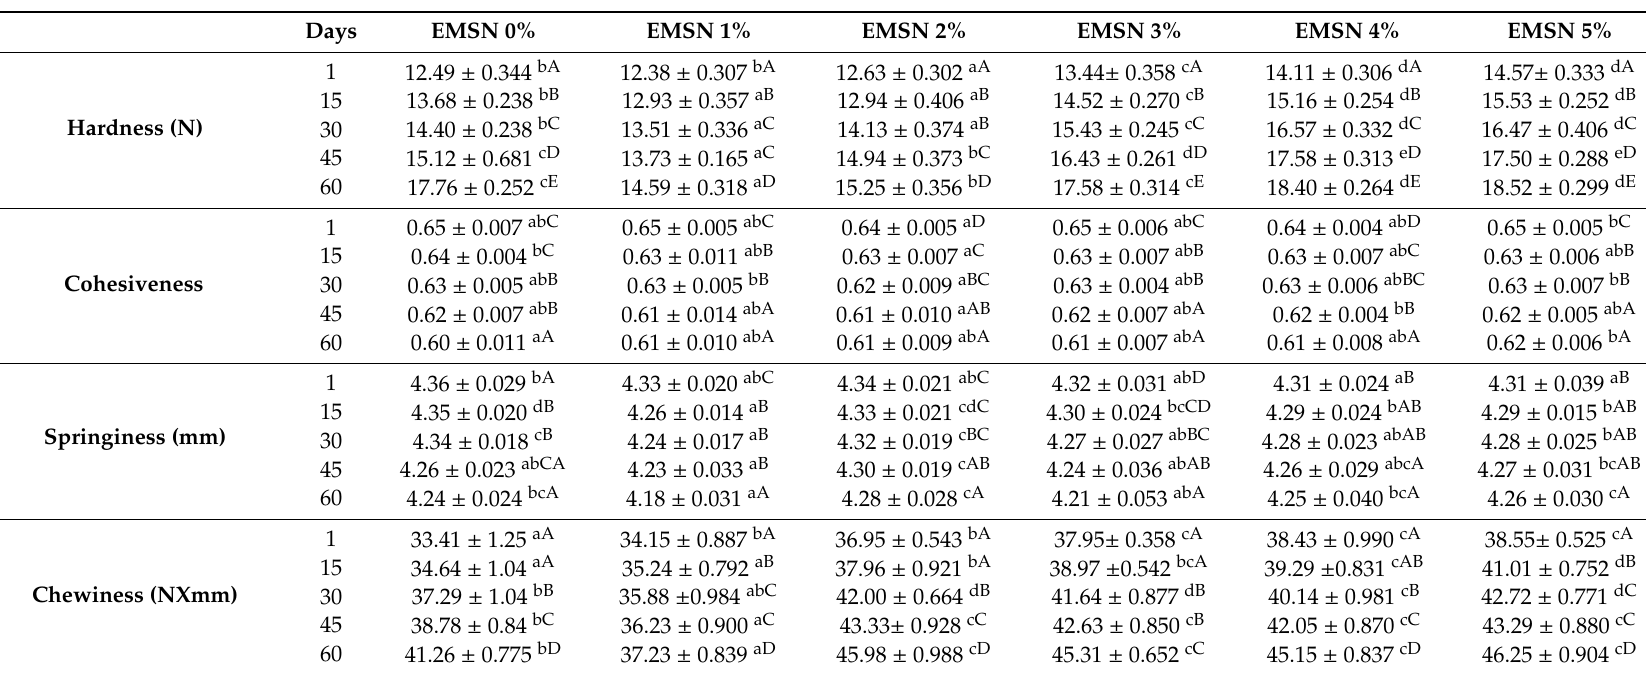
Table 3. Texture profile analysis (TPA) for the parameters hardness, cohesiveness, springiness, and chewiness in the emulsified meat system with